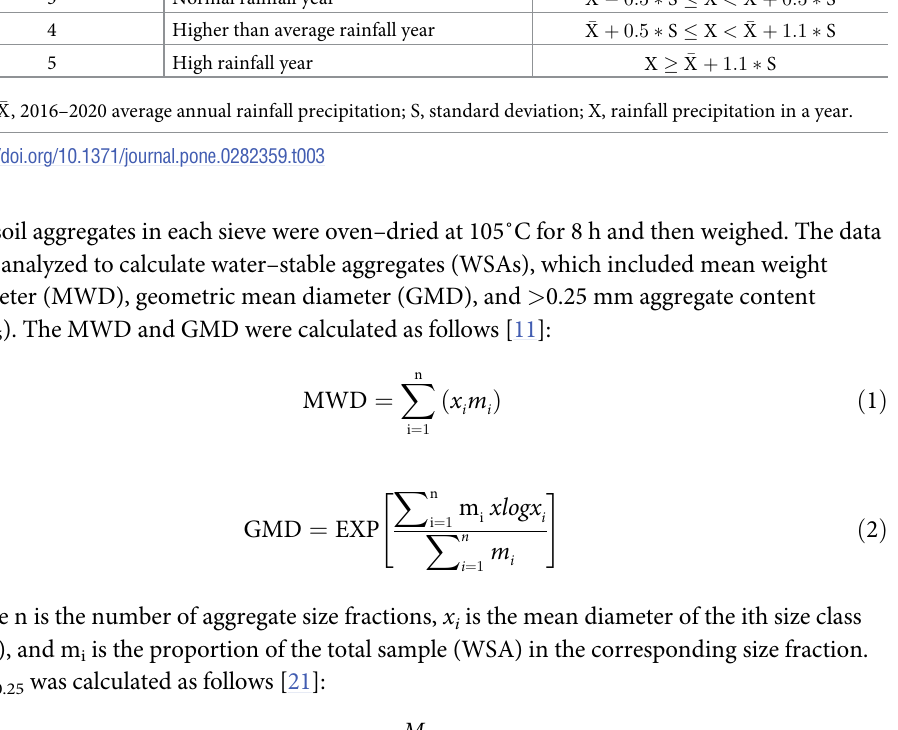
is the mean diameter of the ith size class i